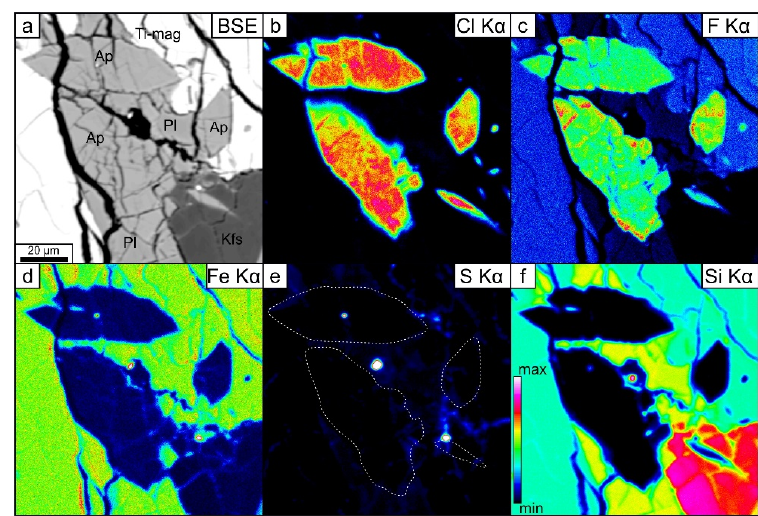
Figure 3. BSE image ( a ) and X-ray compositional maps ( b – f ) of apatite in NWA 10153. All images are at identical scales. The color scale representing increasing element concentration in the lower left corner of X-ray compositional map ( f ) is common to all X-ray maps; however, the intensities are not necessarily correlated. The white dashed line in map ( e ) was applied to highlight apatite. Abbreviations according to